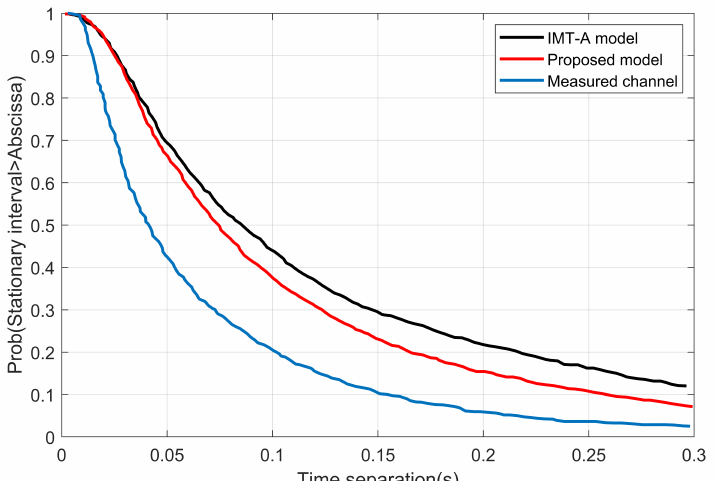
Figure 8. The stationary interval of the proposed model, measured channel, and the IMT-A chan- nel